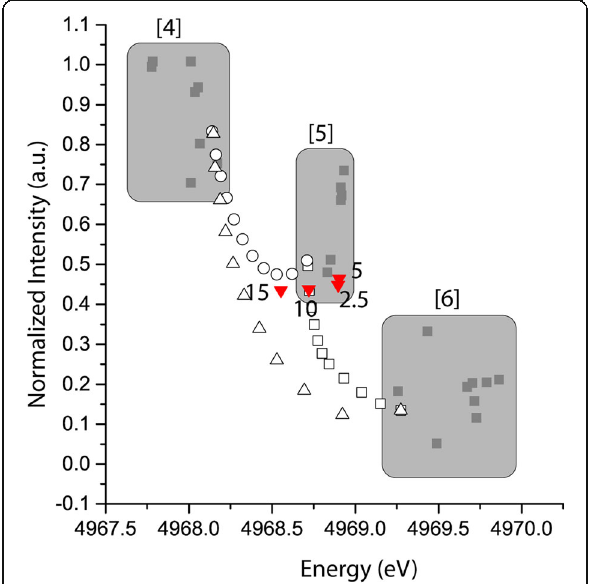
Fig. 6 Ti k-edge X-ray absorption fine structure (XAFS) pre-edge peak positions and mixing curves. The Ti pre-edge feature is sensitive to the coordination environment and is used to assess average Ti 4+ coordination in the experimental glasses. Grey regions and grey, filled symbols are the pre-edge peak positions of minerals and glasses with known Ti coordination (Farges et al. 1996b). White filled symbols are mixing curves between end-member [4] Ti-bearing forsterite, [5] Ti-bearing fresnoite, and [6] Ti-bearing titanite. Red symbols are the peak positions of NS8 glasses with the mol% TiO 2 indicated next to the symbols. As Ti concentration increases, the peak positions shift along a trend similar to the mixing of [4] Ti and [5] Ti, indicating the average coordination of Ti in the glasses decreases with increasing bulk TiO 2